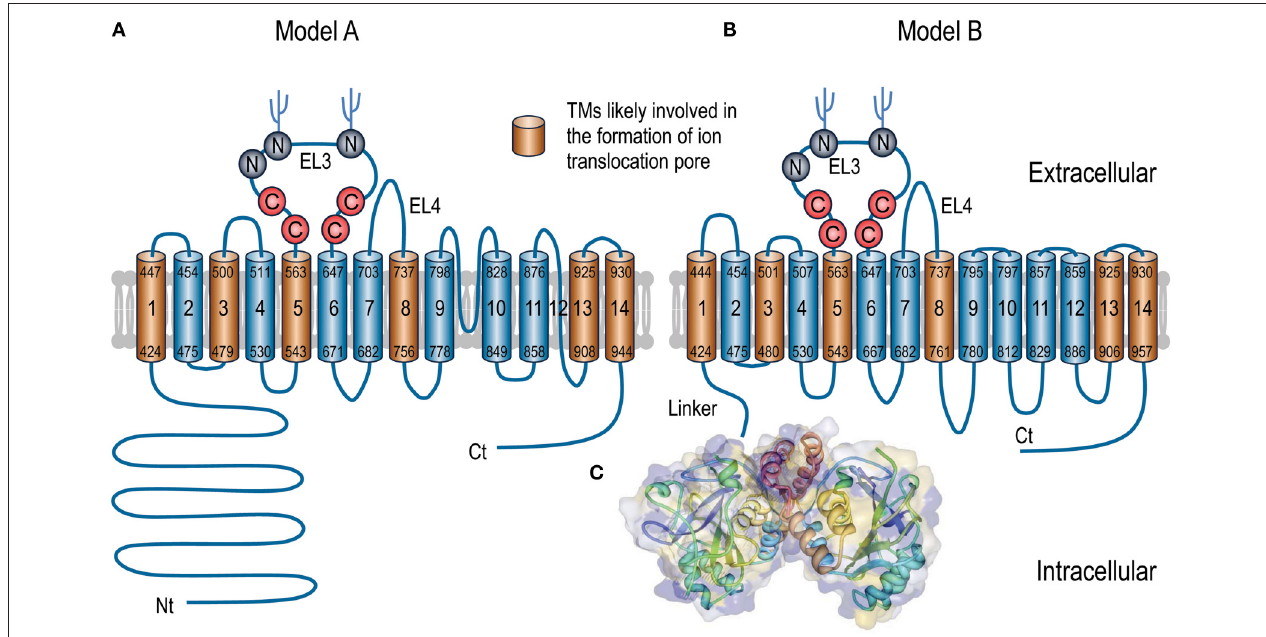
FIGURE 2 | Putative models of topological organization of SLC4 transporters (A,B) and 3D crystal structure of Nt domain of AE1 (C). For the convenience to compare the sequence assignments, both topological models A and B use human NBCe1-A for illustration. The numbers (according to accession #AAC51645.1) at both ends of each putative TM indicate the proposed initial and last residues of the TM in each model. Experimentally, model A is largely based on the studies with AE1 by N-glycosylation scanning mutagenesis (Popov et al., 1997, 1999) and cysteine scanning mutagenesis (Tang et al., 1998; Zhu et al., 2003). The front half of TMD (TM1-TM9) of model B is basically consistent with model A except for some minor deviations in the boundaries of TMs. The assignment of the Ct half from EL5-TM14 in model B is based upon the cysteine-scanning mutagenesis study on NBCe1 (Zhu et al., 2010a,b) and the structural modelings with AE1 (Barneaud-Rocca et al., 2013; Bonar et al., 2013). Panel C shows the 3D structure of the dimer of the Nt domain of human AE1. The model was created based on the crystal structure of the Nt of human AE1 (PDB ID #4KY9) using Protein Workshop 4.2.0 from RCSB Protein Data Bank (Moreland et al., 2005). The hydrophobicity surface (blue least, red most) was generated by using a Euclidean Distance Transform (Xu and Zhang, 2009).